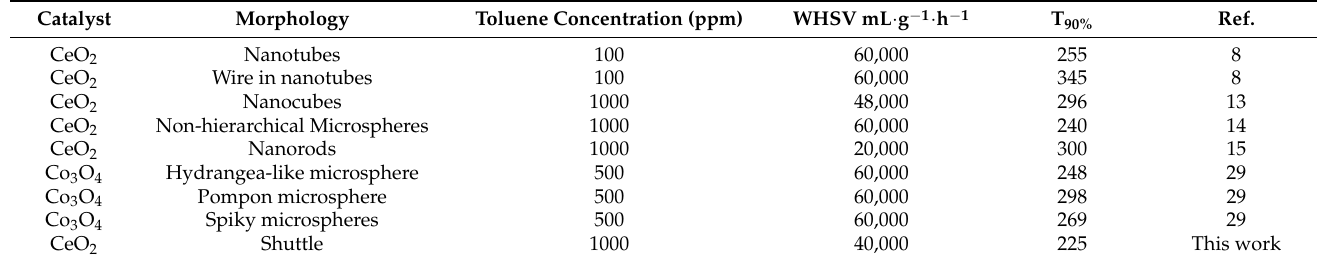
Table 3. Catalytic oxidation of toluene over different morphologies